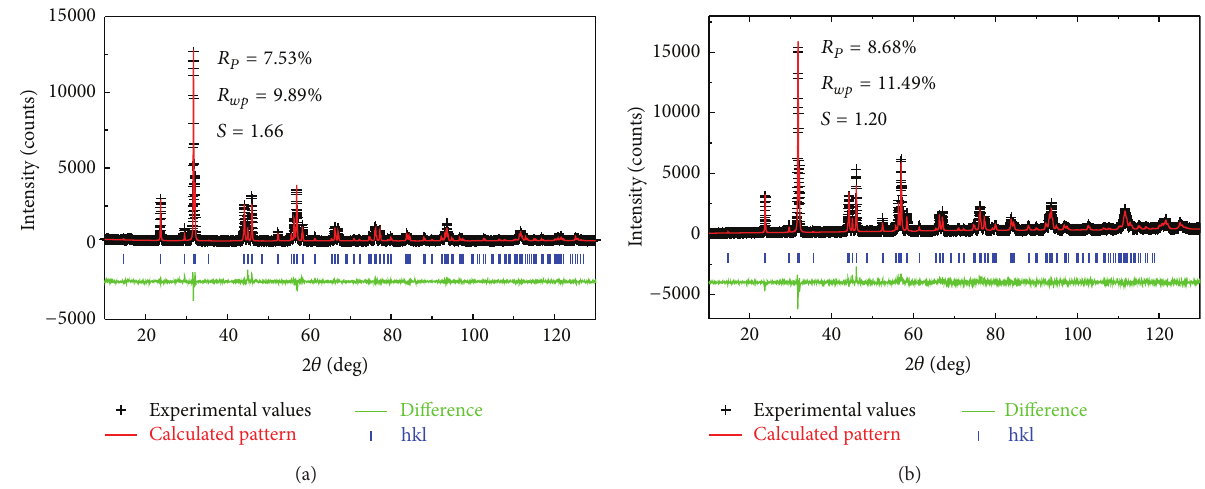
Figure 3: Final Rietveld refinement patterns of (a) Nd 1.85 Ce 0.15 CuO 3.975 powders without treatments and (b) Nd 1.85 Ce 0.15 CuO 3.961 powders ammonothermally treated at 54 ∘ C in sodium ammonia solutions. Black crosses represent the experimental values and the red solid line the calculated pattern. The green solid line at the bottom is the difference between the experimental and calculated data. The blue bars represent the position of Bragg